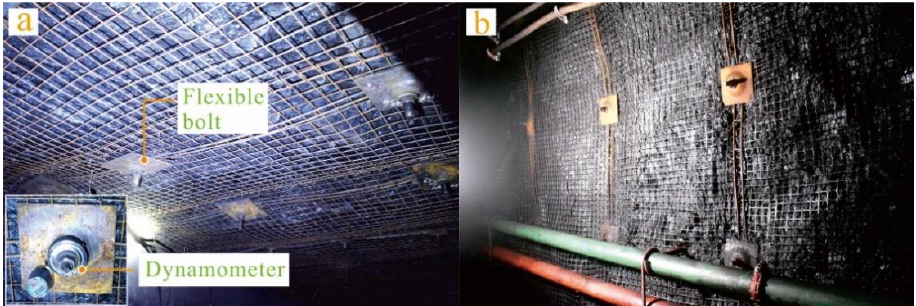
Figure 17. Field photos of testing roadway: ( a ) roof and ( b ) rib.